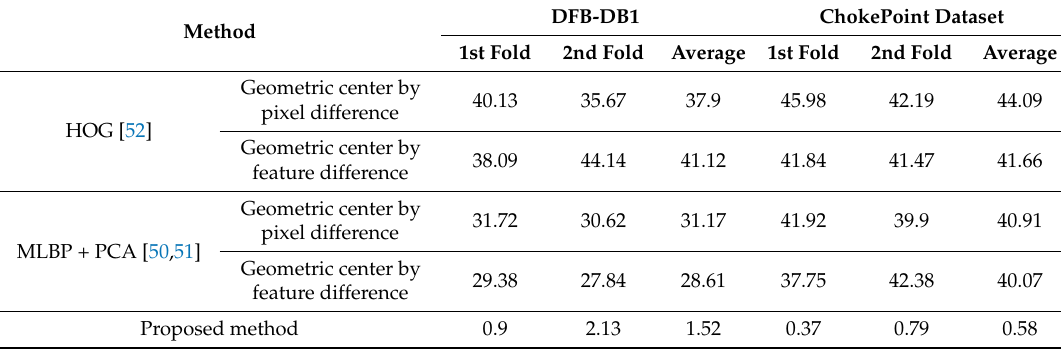
Table 12. Comparison of EERs by proposed and previous methods (unit: